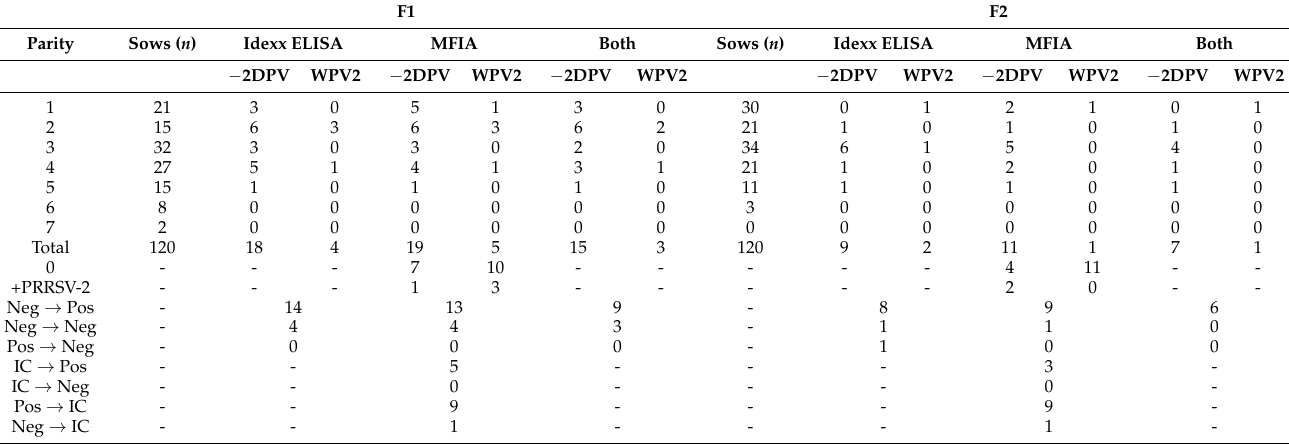
Table 2. Distribution of Seronegative Animals. Number of sows from Farms 1 (F1) and 2 (F2) that tested negative in the serological assays (Idexx ELISA and MFIA) before ( − 2DPV) and after (WPV2) mass vaccination with an MLV PRRSV-1 vaccine and by parity. Columns representing sample-to-positive ratios (S/P) for negative animals in both assays are included ( n = total number of tested sows in each parity. “Both” refer to if Idexx ELISA and MFIA agrees with the serological PRRSV-1-status of the sow before and after mass vaccination. “0” represents PRRSV type indistinguishable values of MFIA. “+PRRSV-2” indicates sows with a ratio indicating dominance of PRRSV-2 antibodies. “Neg → Pos” indicates seroconverting animals, “Neg → Neg” indicates remaining negative antibodies, “Pos → Neg” indicates sows that shift from seropositive to seronegative and “IC” indicates inconclusive type of